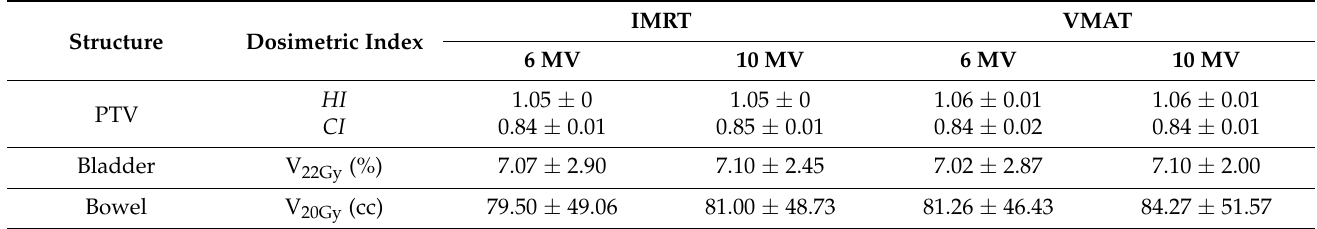
Table 4. Mean ± 1 standard deviation of the clinically used plan quality indices and dose–volume metrics, related to the HFRT (5 × 5 Gy) treatment protocol for preoperative rectal cancer IMRT and VMAT irradiation with 6 MV or 10 MV photon